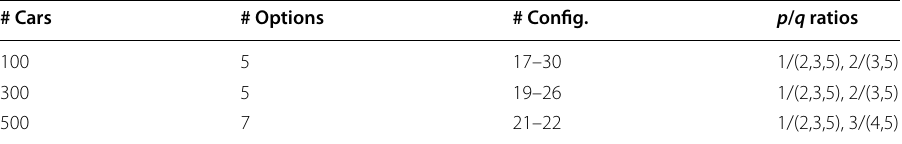
F&O, R&F F&O, B&C B&C and R&F B&C, and the threshold value returned + + + +